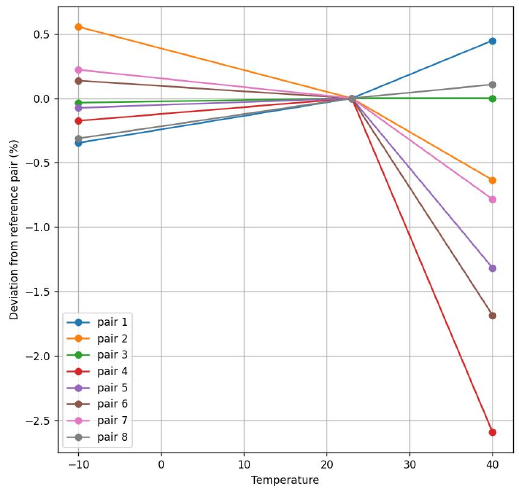
Figure 16. Flow deviation between 500 kHz pairs at 560 L/h.